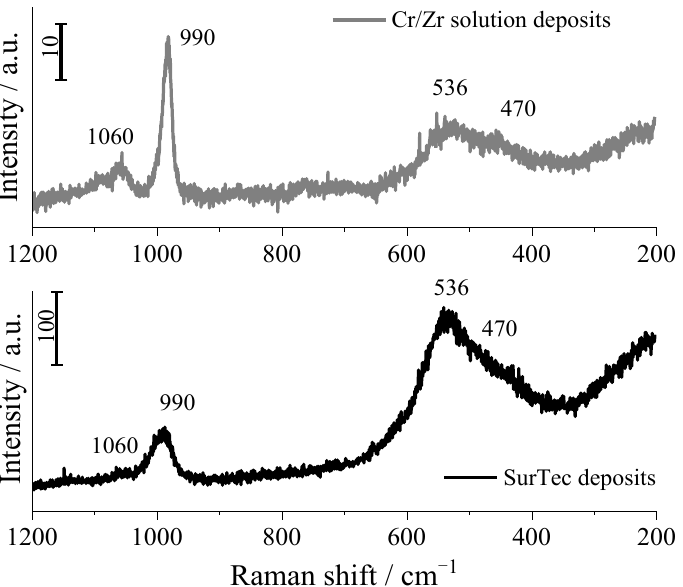
Figure 11. Raman spectrum of the solution deposits from the SurTec 650 ChromitAL and in-house Cr/Zr solution deposits when the pH value of the bulk solution was more than pH 7.